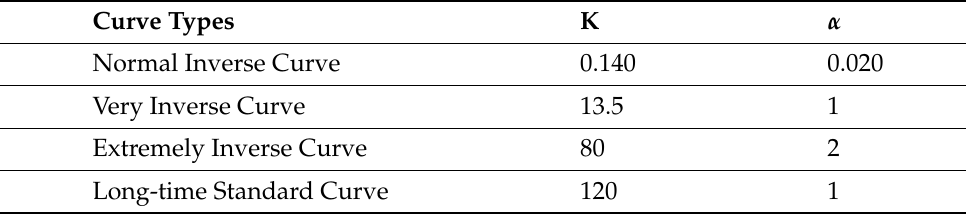
Figure 2. Instantaneous overcurrent relay block model. Table 3. IDMT curve